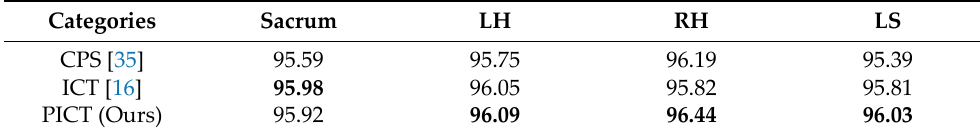
Figure 7. The mean DSC score point-fold line of different methods on CTPelvic1k dataset with dif- ferent ratio labeled cases. Table 5. Comparison of DSC score (%) of CPS, ICT, and PICT on CTPelvic1k with 10 labeled images as examples. The bold fonts indicate the best results of the comparing variants.